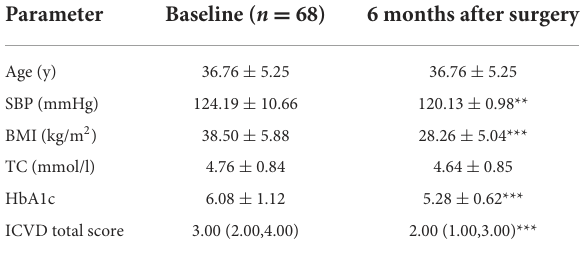
TABLE 2 Baseline and 6-month-post-operative characteristics in the male subgroup.